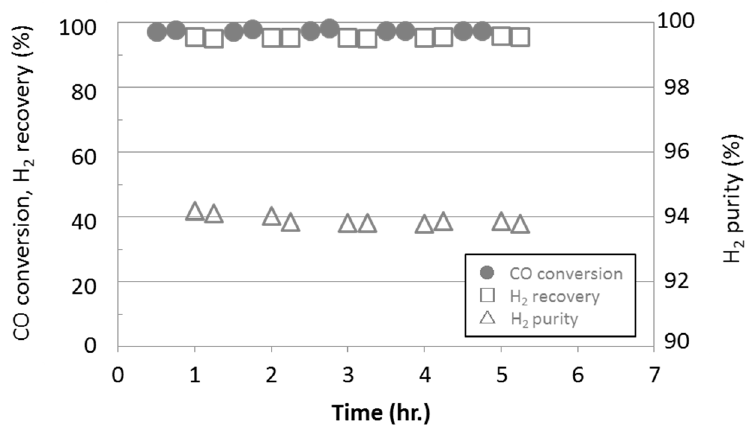
Figure 12. Water gas shift reaction by membrane reactor installed the TMOS-derived silica membrane.